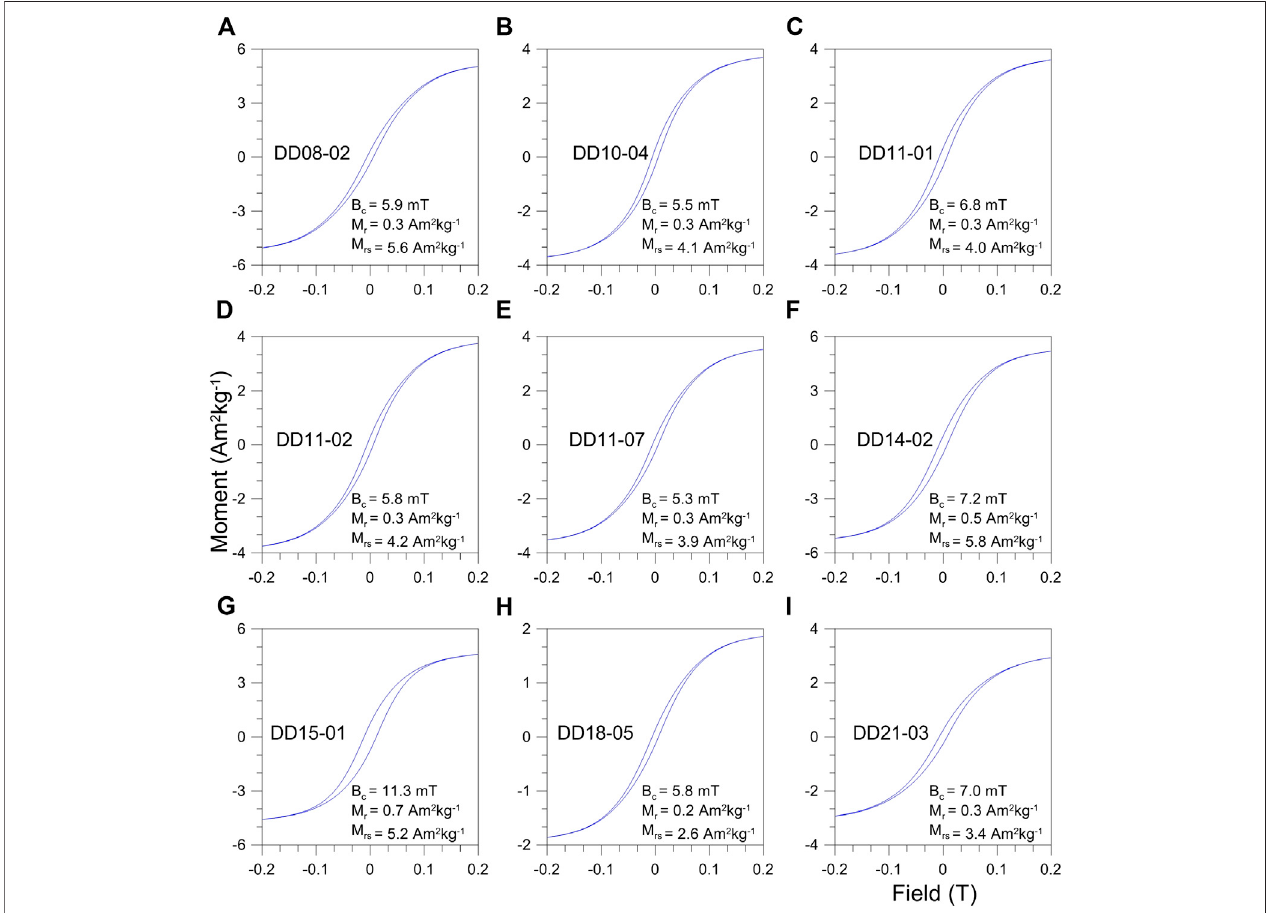
FIGURE 2 | Representative hysteresis loops of basalt samples at the Dadi section. The saturation fi eld is ± 1 T. B c , coercivity; M r , remanent magnetization; M rs , saturation magnetization.